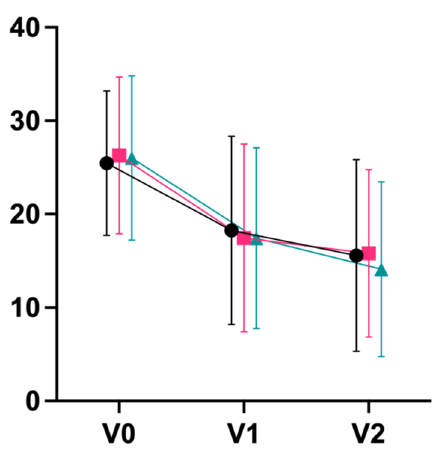
Figure 6. Physical Wellbeing B-LR (Mean ± SD).